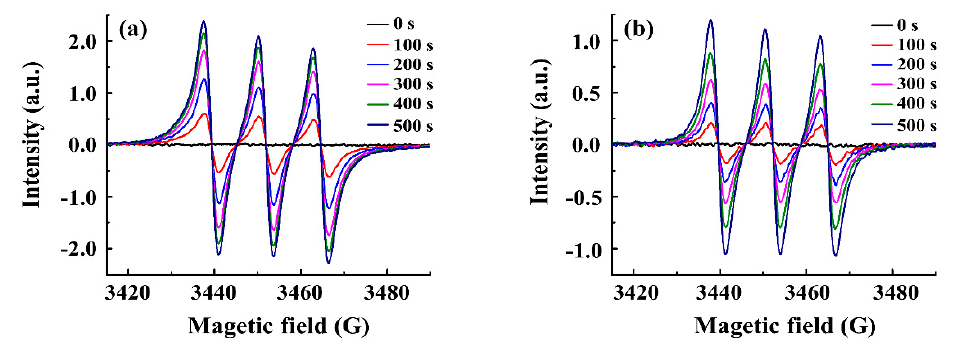
Figure 3. Electron paramagnetic resonance (EPR) spectra of the trapped NO from Ru-Lbpy 1 ( a ) and Ru-Lbpy 2 ( b ) with Hg lamp irradiation at 0 s, 100 s, 200 s, 300 s, 400 s, 500 s, respectively.